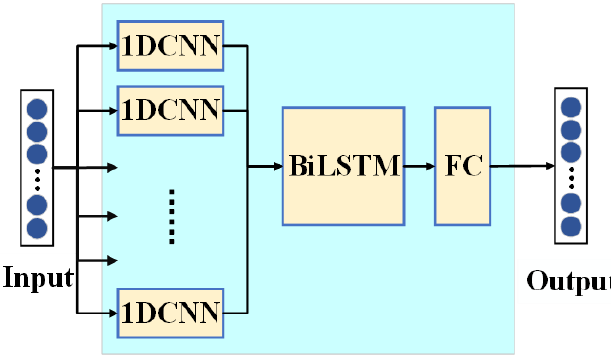
Figure 4. Model structure diagram.